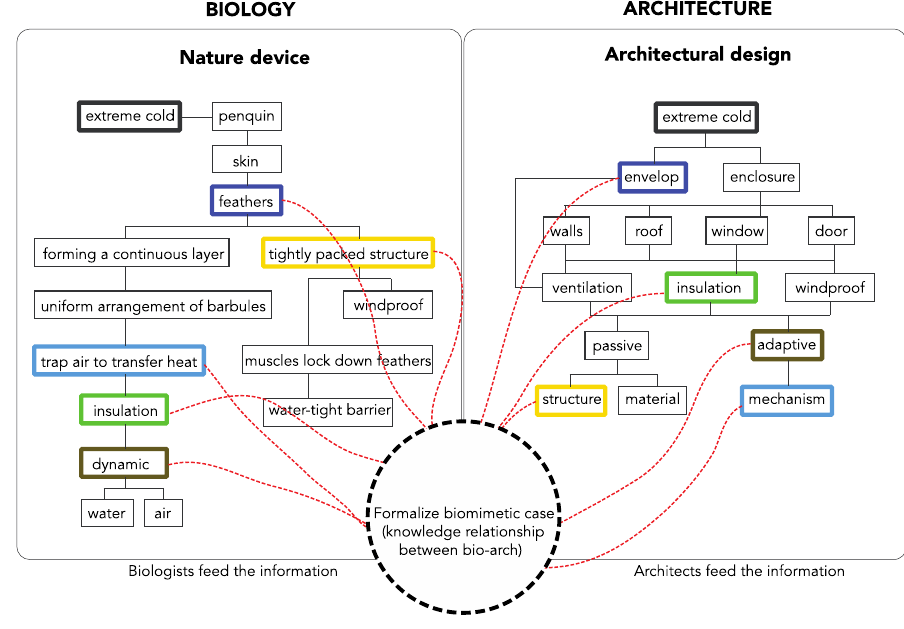
Figure 7. An example of a small network within a data analysis platform (computing) searches and formalizes the relationship knowledge between biology and